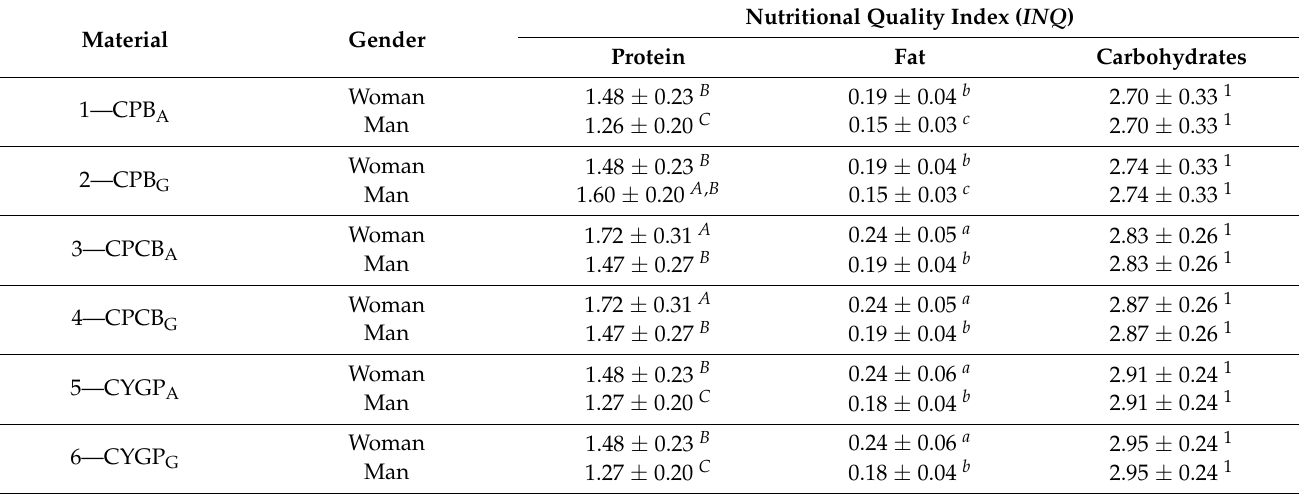
Table 6. Average of the Nutritional Quality Index ( INQ ) for freeze-dried products formed on the basis of vegetables produced with